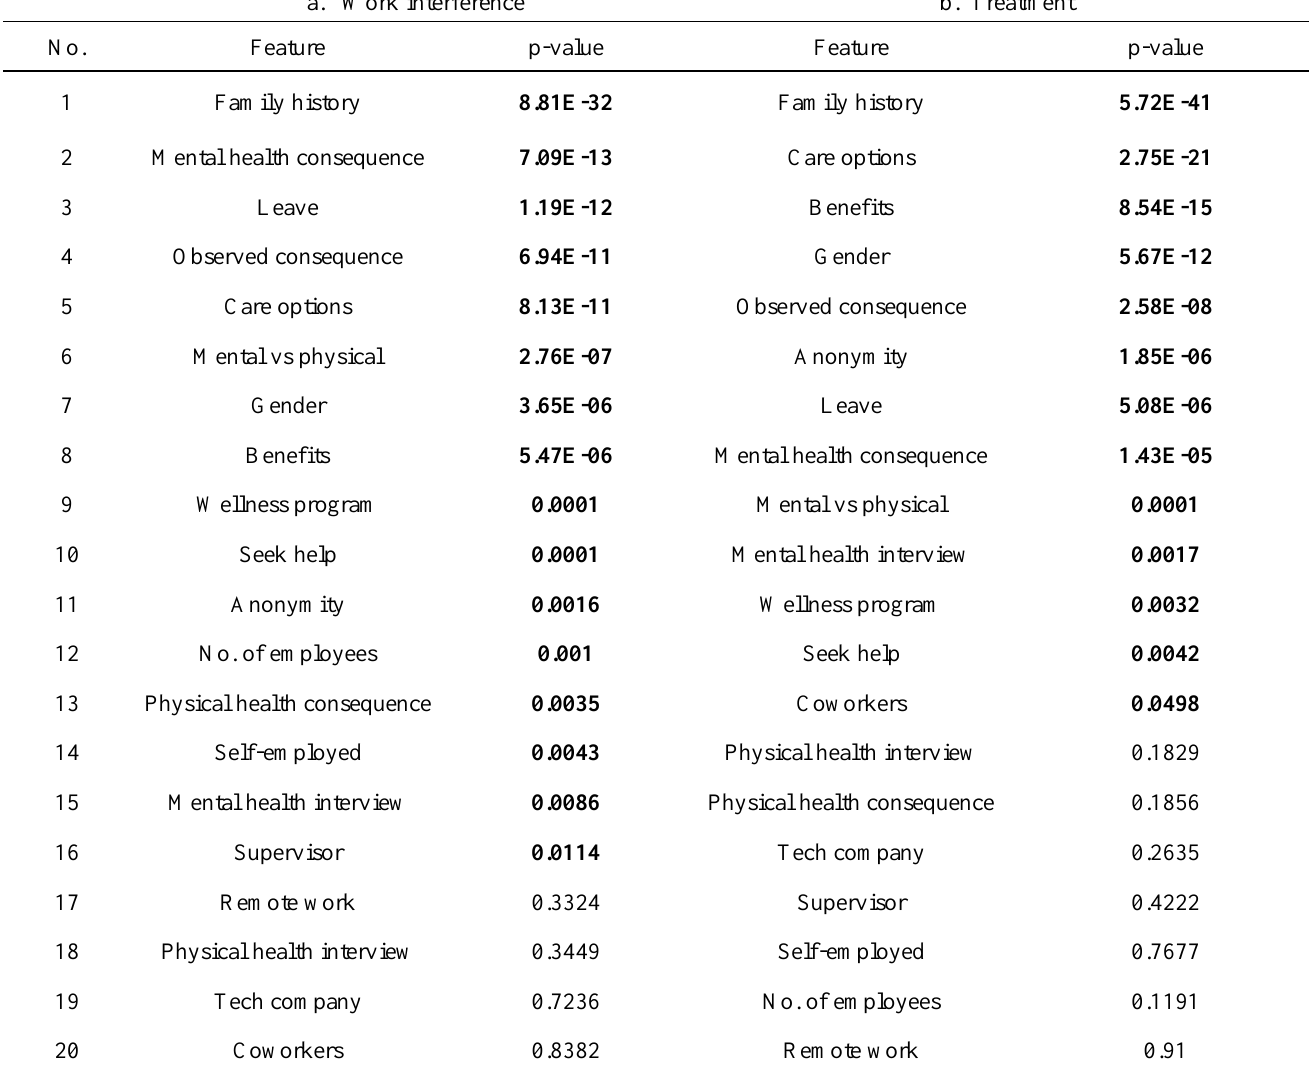
Statistical significance of features using the Kruskal-Wallis test. Features are sorted in terms of their significance from the lowest p- value to the highest against a) Work interference and b) Treatment. Bold represents statistical significance (p-value <